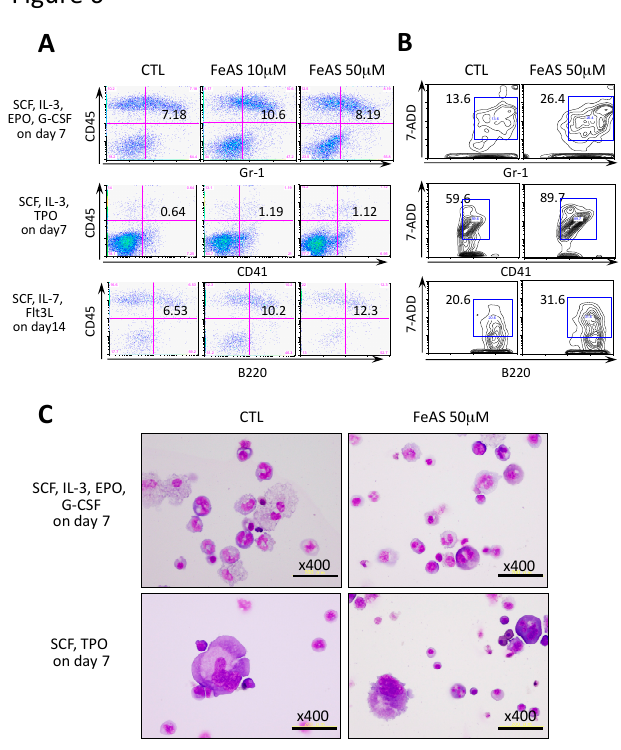
Figure 6. FeAS shows little influence on the development of myeloid cells, megakaryocytes, and B lymphocytes. ( A , B ) Myeloid cells, megakaryocytes, and B lymphocytes were induced to develop under the indicated conditions using the OP9 system, and the respective lineage markers, Gr-1, CD41 and B220, were examined by flow cytometry analysis. Reactivity to 7-AAD was also analyzed by flow cytometry. The percentage of each fraction is indicated. ( C ) The morphology of granulocytes and megakaryocytes treated with FeAS obtained by the above-described culture conditions were analyzed.